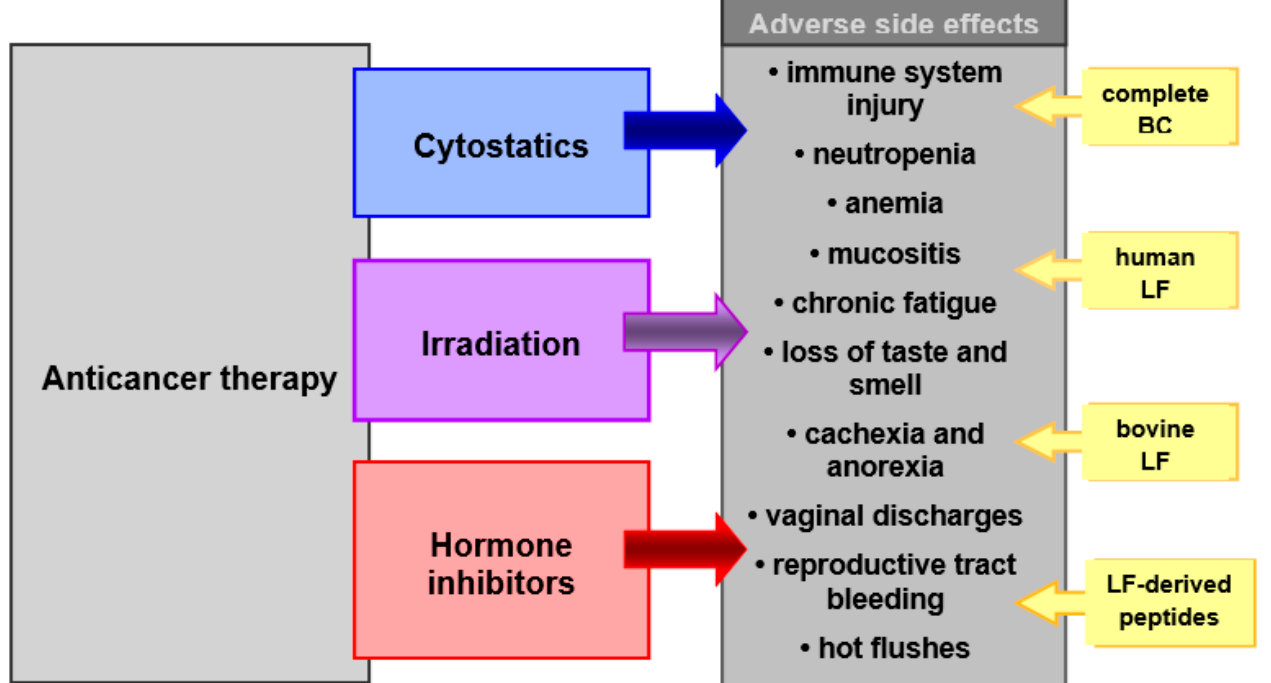
Figure 1. Chemotherapeutic agents, irradiation and anti-hormone agents in therapy of cancer. BC and its bioactive constituents (LF and others) may be used as supportive care in prevention and treatment of adverse side effects of these therapies.